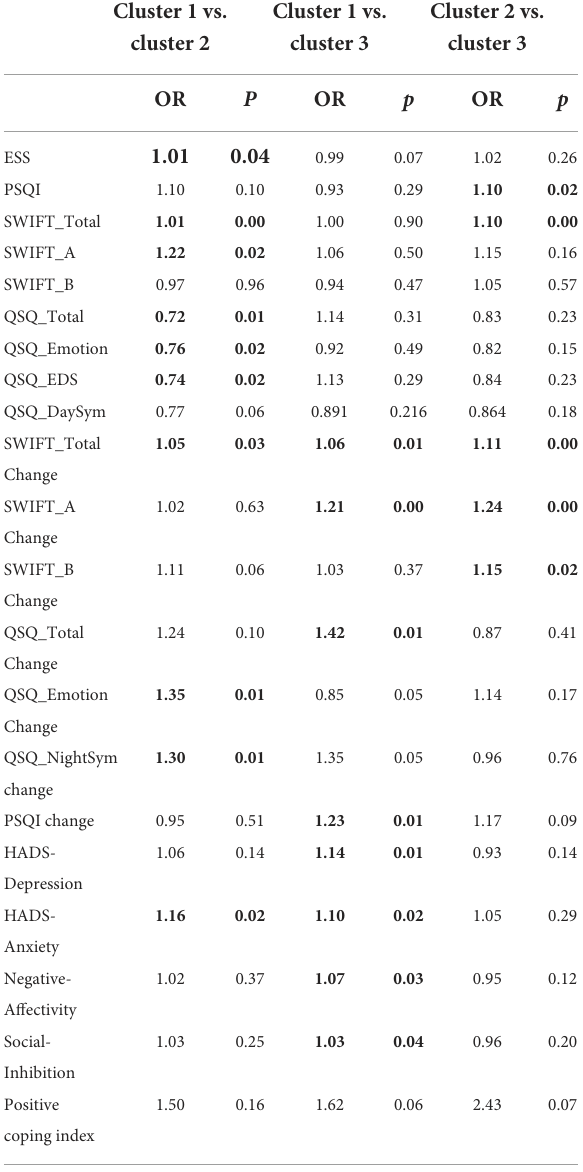
TABLE 7 Multinominal logistic regression for predictors with three patterns. Cluster 1 vs. Cluster 1 vs. Cluster 2 vs. cluster 2 cluster 3 cluster